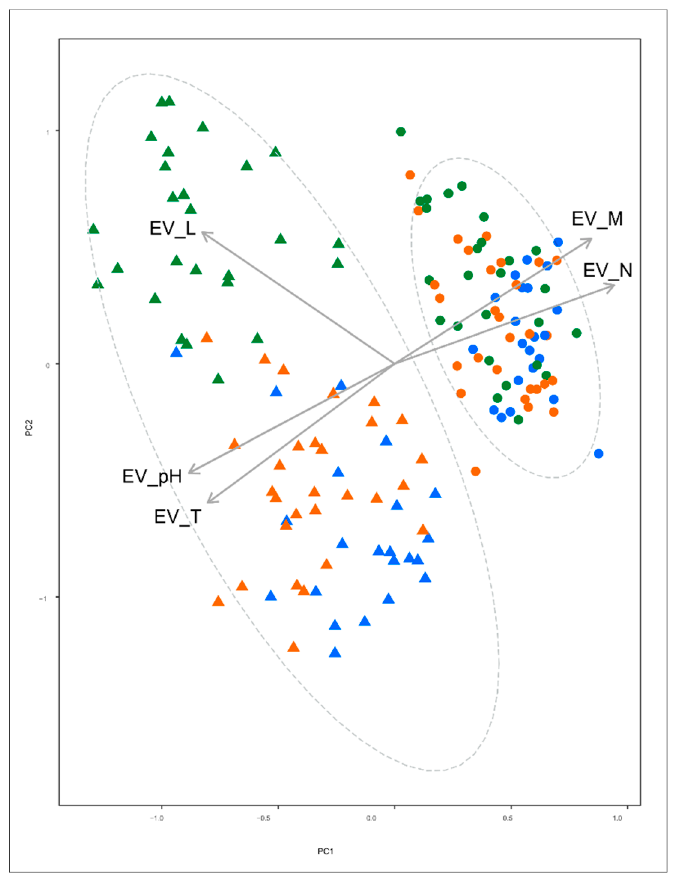
Figure 2. The principal component analysis (PCA) of species composition of the oak–lime–hornbeam forest communities in 1949 (triangles) and 2018 (dots), with passively fitted community-weighted means of Ellenberg’s Indicator Values for moisture (EV_M), pH (EV_pH), temperature (EV_T), light (EV_L), and nutrients (EV_N). Green: Querceto-Carpinetum caricetosum pilosae , orange: Querceto-Carpinetum typicum , and blue: Querceto-Carpinetum stachyetosum silvaticae.